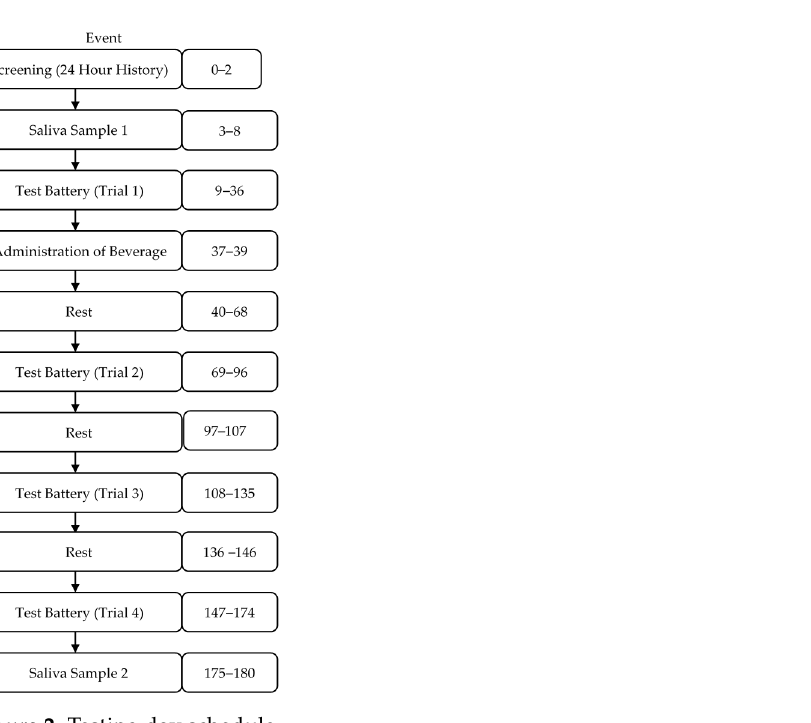
Figure 2. Testing day schedule.